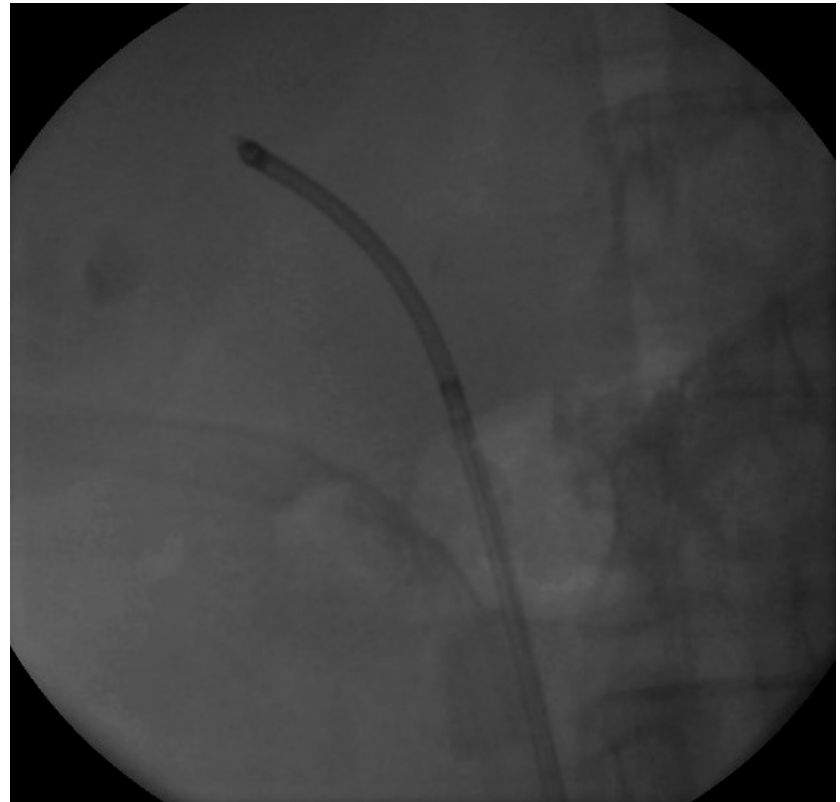
Figure 3. Fluoroscopy Image at the end of the lithotripsy.